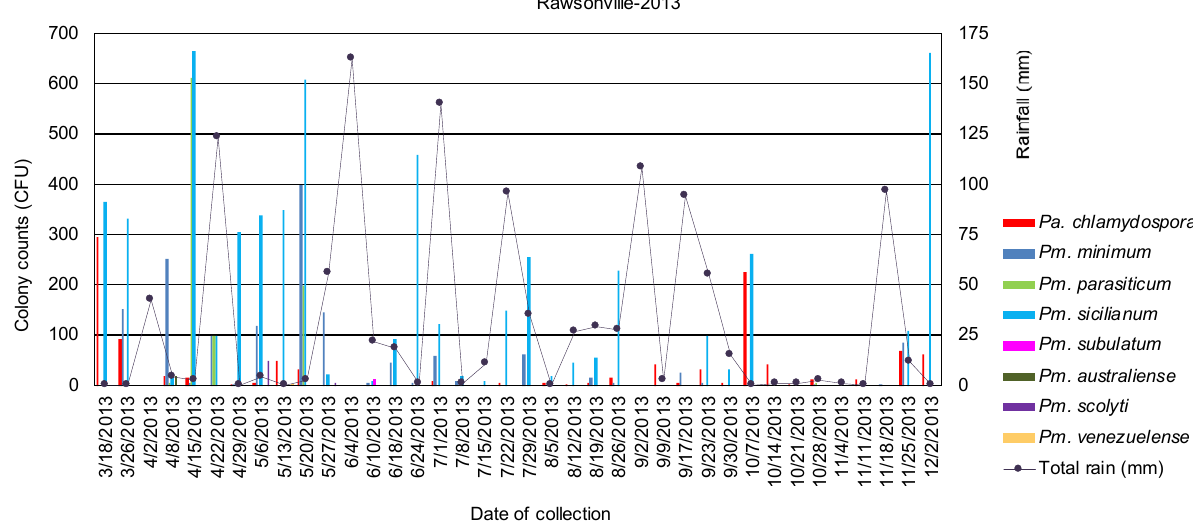
Figure 12. Phaeomoniella and Phaeoacremonium spp. cfu cultured from five vaseline coated microscope slides affixed to the cordons on each of five vines in a vineyard in Rawsonville, Western Cape province in 2013. The slides were replaced weekly. Each bar represents the total number of cfu cultured on three Petri dishes. Not clear on the graph, the detection date for Pm. australiense is 08/04 and for Pm. ven- ezuelense is 13/05.